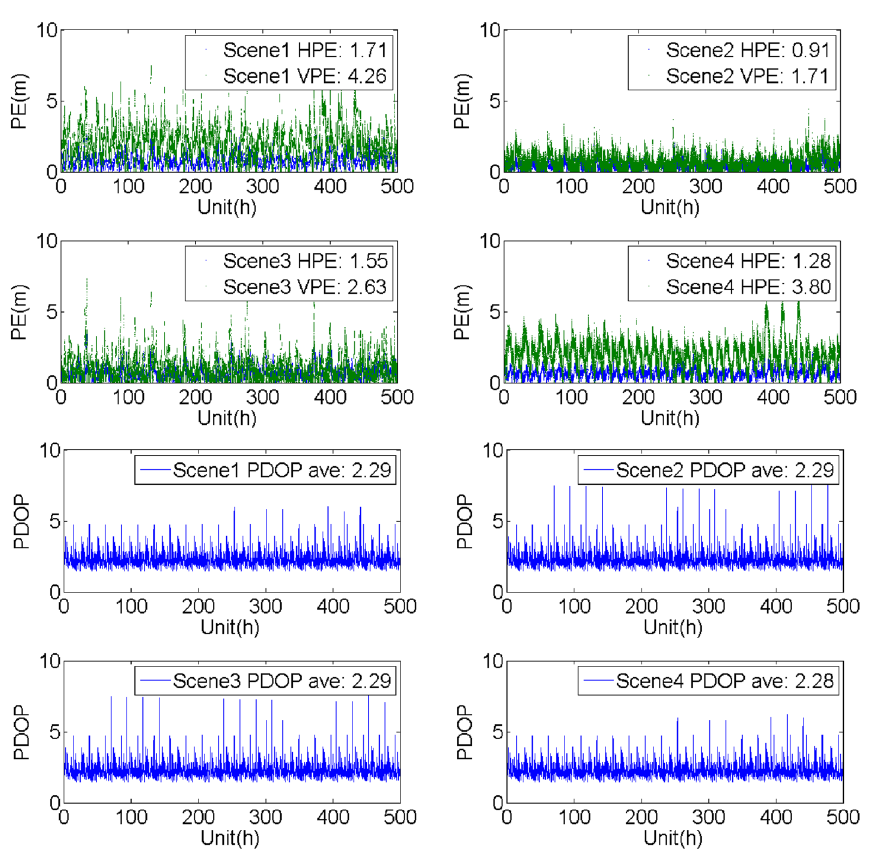
Figure 9. Evaluation of the PE and PDOP under different scenes in Beijing from Dec 11 to 31,